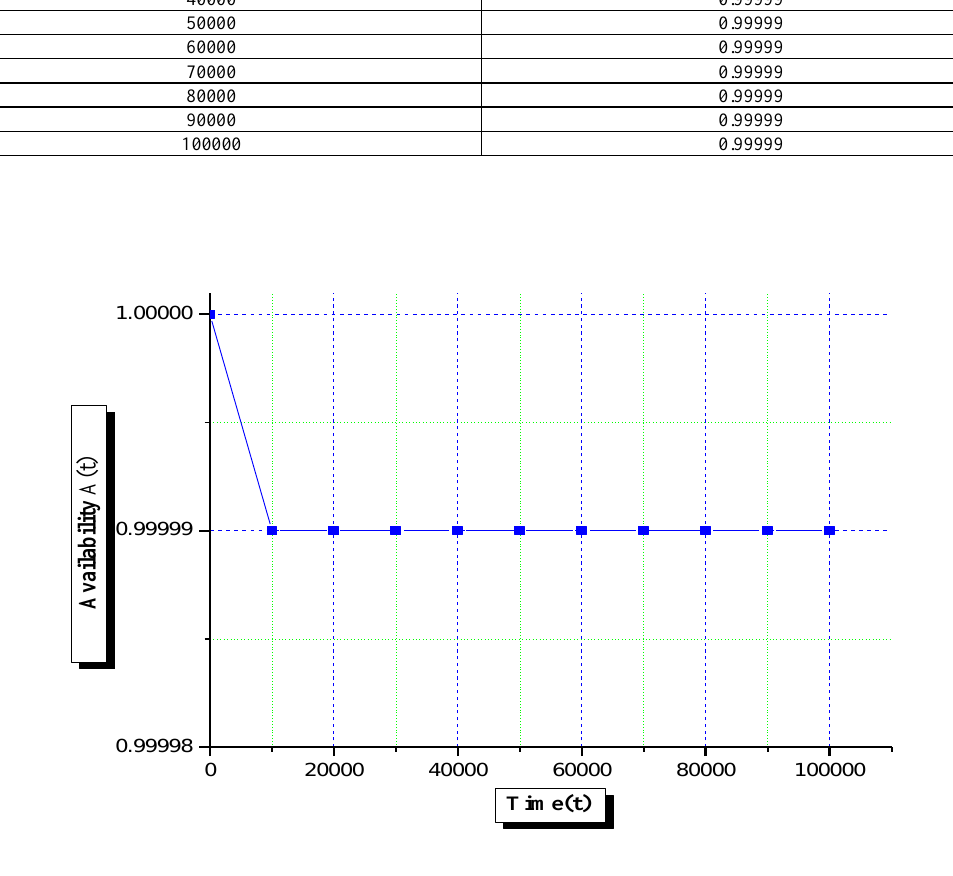
Figure 3. Availability of the system w.r.t.